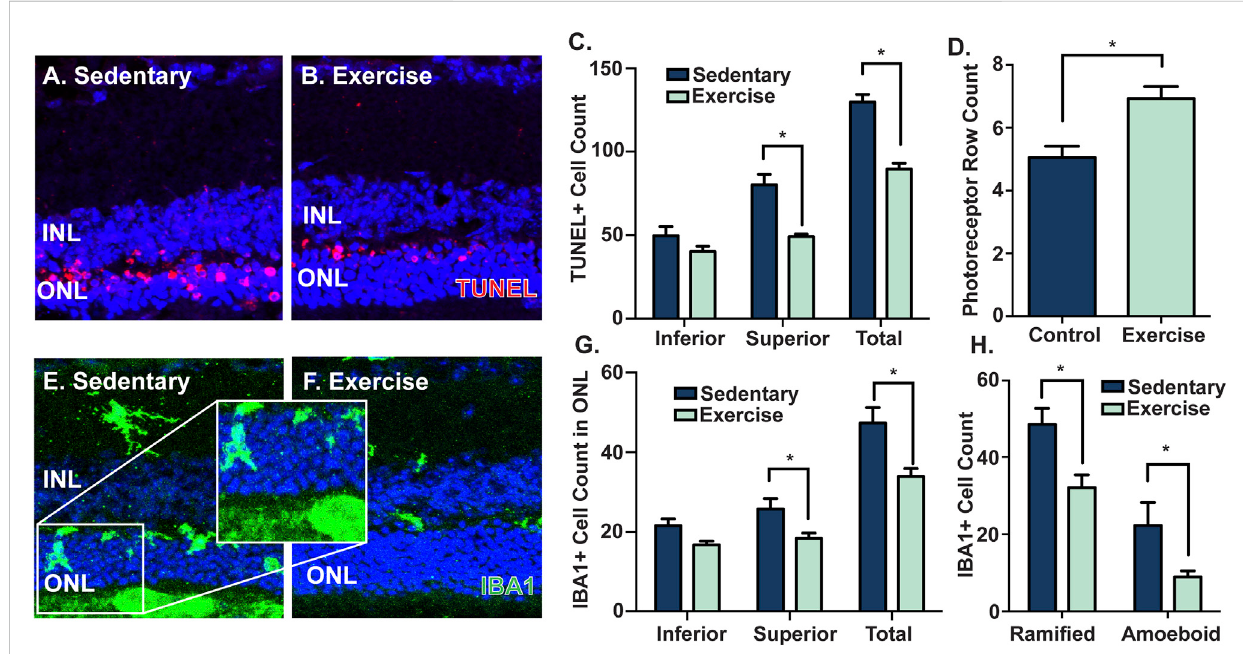
FIGURE 3 Voluntary exercise protects the retina against photoreceptor cell death and in fl ammation. Mice with access to voluntary exercise had decreased levels of photoreceptor cell death, as shown in (A – B) representative confocal images and quanti fi ed by (C) reduced numbers of total and superior TUNEL + cells (red) in the ONL, and (D) increased numbers of photoreceptor nuclei rows, compared to sedentary controls. Further, exercised mice had reduced levels of IBA1 + cells (green) in the ONL, as shown by (E – F) representative confocal images, and quanti fi ed by (G – H) decreased numbers of total, superior, rami fi ed and amoeboid IBA1 + cells in the ONL. *Signi fi cance using a Student ’ s t -test, p < 0.05 and error bars indicate SEM. Scale bar = 50 μ M. n =